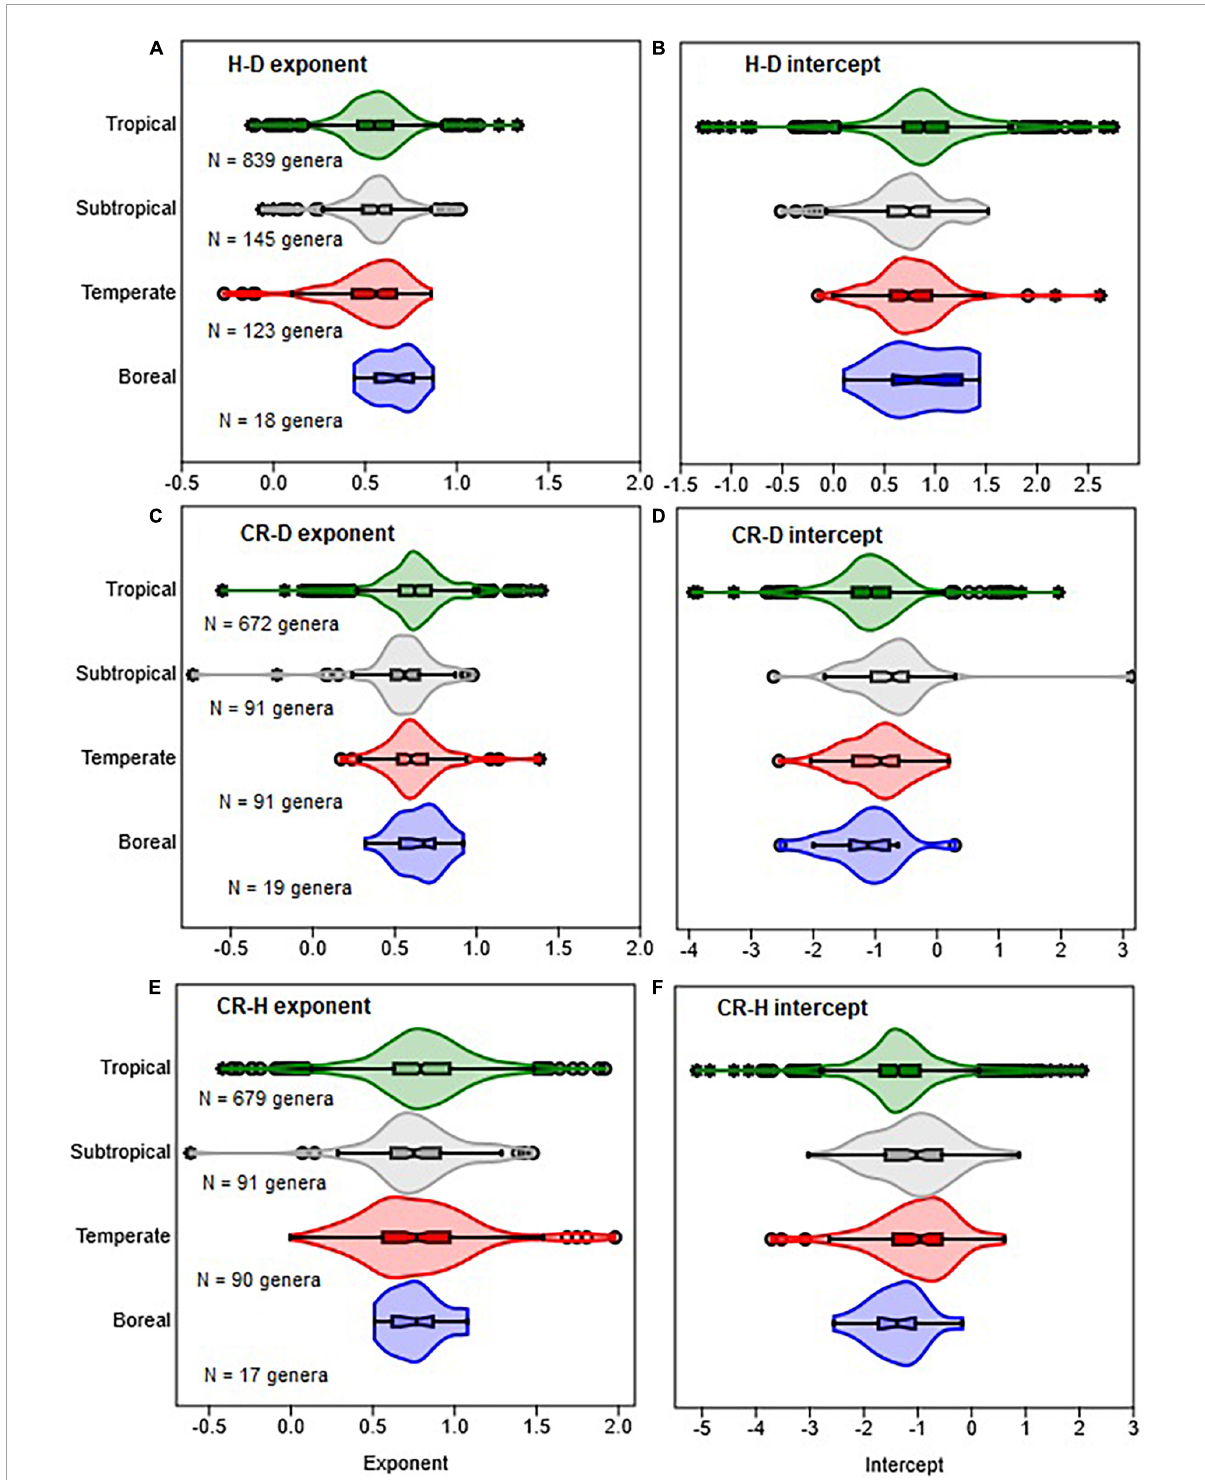
FIGURE2 Comparison of climate zones in terms of the distribution of the allometric parameters of the scaling of height with stem diameter (H–D), crown radius with stem diameter (CR–D), and crown radius with stem height (CR–H). The distributions of exponents are shown in (A,C,E) , while intercepts are in (B,D,F) . The box and whisker plots display the median and its 95% CI (notches), lower quartile, upper quartile, extreme values, and outliers (O and *). Distributions in all cases are based on OLS estimates of the parameters for each